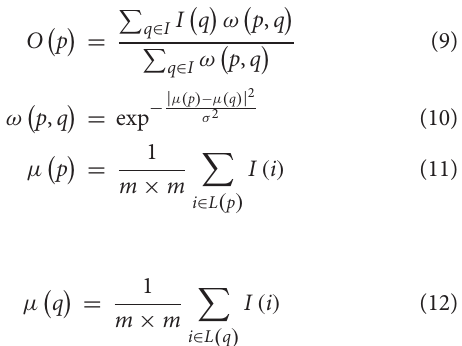
redundant information in the image and can maintain the maximum detail features of the image while denoising. A brief algorithm with superior performance characterizes the method. The basic idea is that the estimate of the current pixel is obtained by a weighted average of pixels in the image that has a similar neighborhood structure to it. It can effectively remove most of the noise on crop leaves for other reasons and is an effective method for removing crop disease image